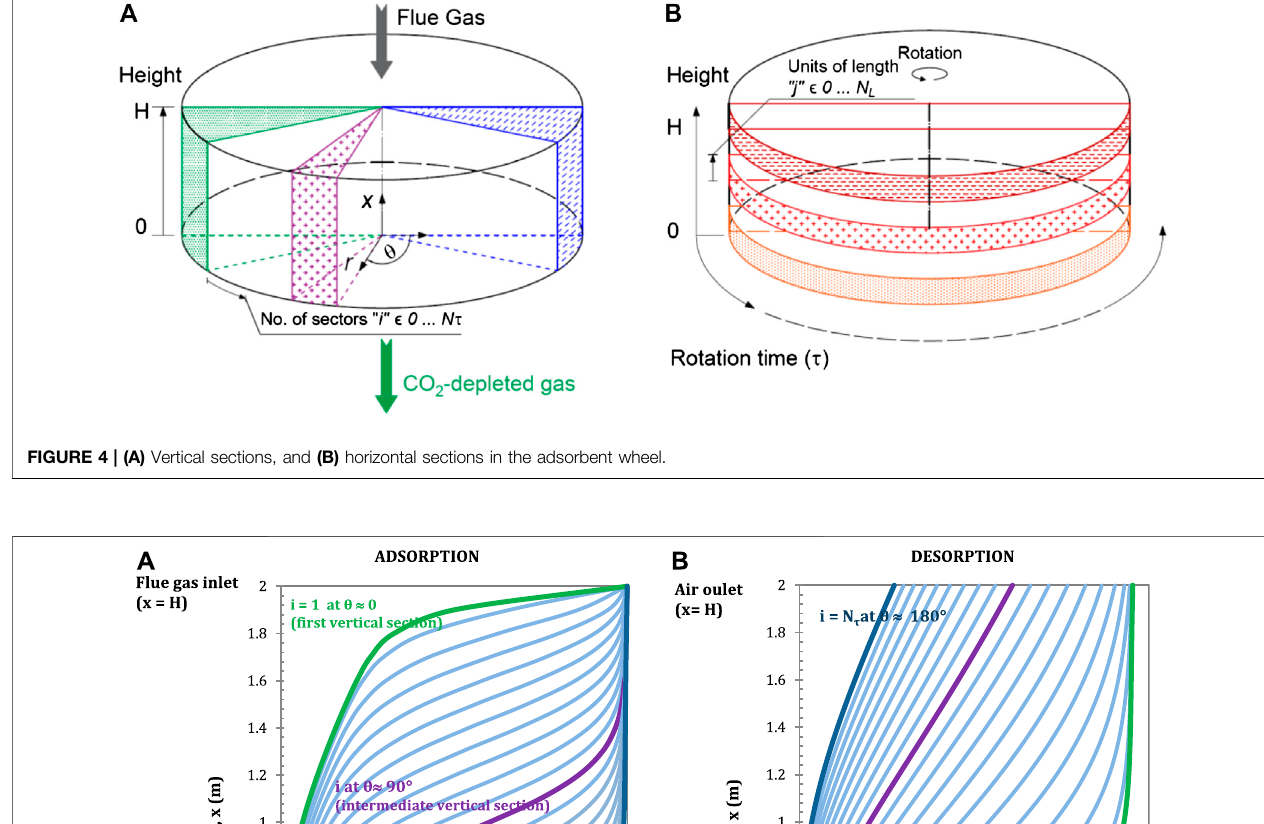
Frontiers in Energy Research |